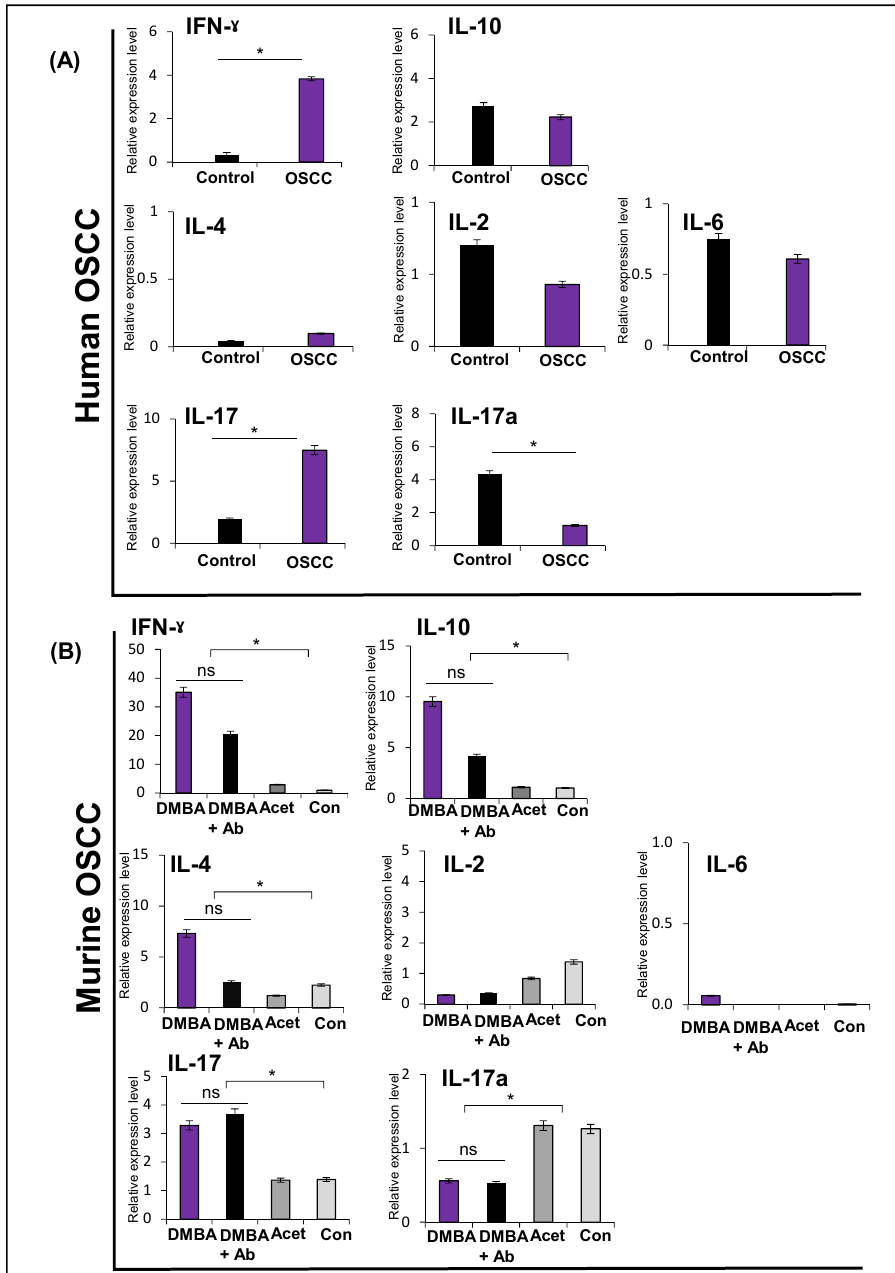
Figure 5. Expression of human and murine cytokines in oral squamous cell carcinoma. ( A ) In human OSCC (n = 15), IFN γ and IL-17 showed significantly higher expression in OSCC than non- tumor adjacent tissue controls (n = 5) whereas IL-17a was low compared to non-tumor tissue controls. IL-10, IL-4, IL-2, and IL-6 expression were not different in OSCC compared to controls. ( B ) In murine OSCC, expression of IFN γ , IL-10, and IL-4 was significantly higher in the DMBA and DMBA+Ab groups compared to the controls. However, IL-2 and IL-6 were not different among groups. IL-17 was also high in both DMBA and DMBA+Ab groups, while IL-17a was low in both DMBA and DMBA+Ab groups. (* = p < 0.05, ns = not significant). SEM are represented as error bars. IL—interleukin; Acet— acetone; and